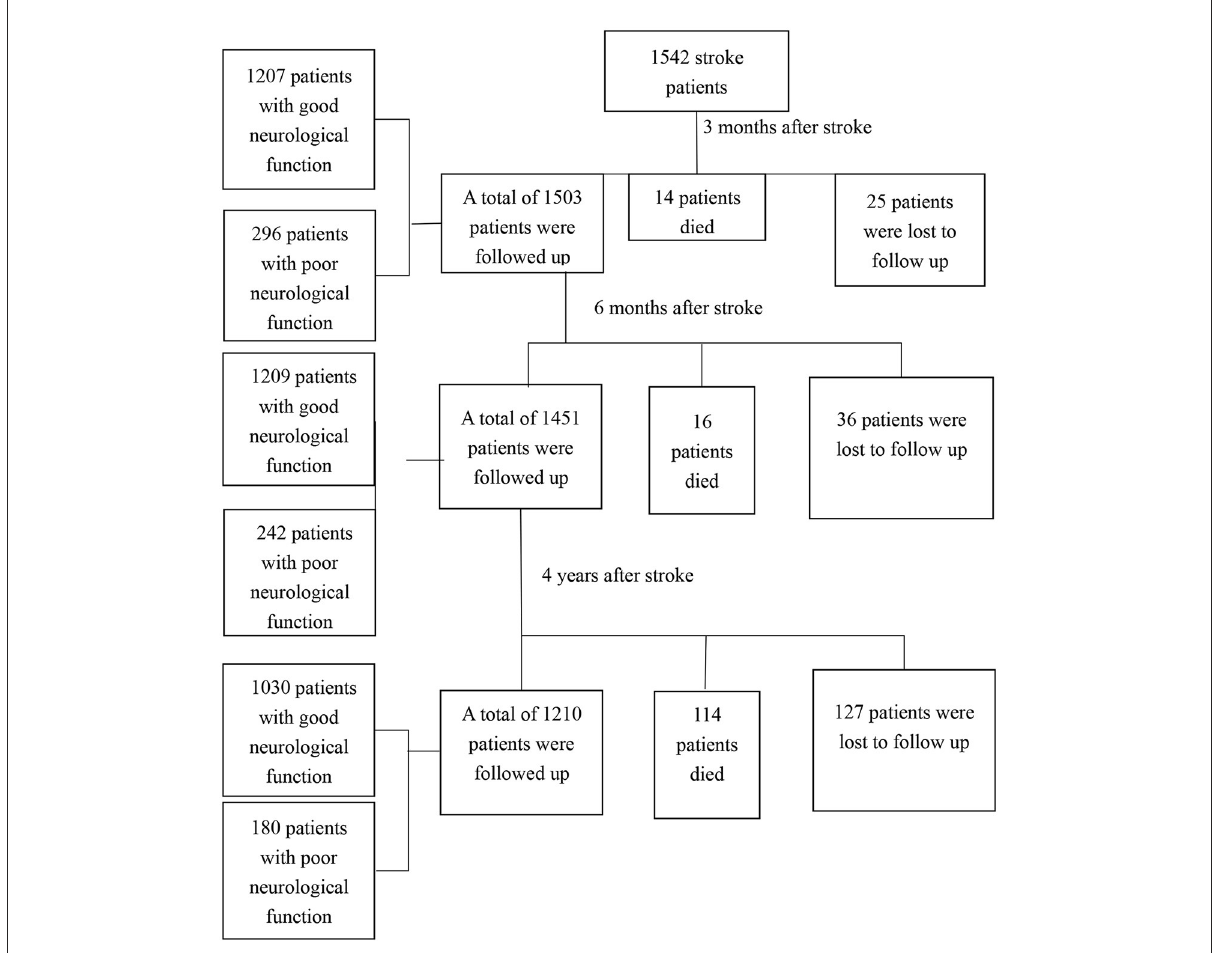
FIGURE2 The flow chart of